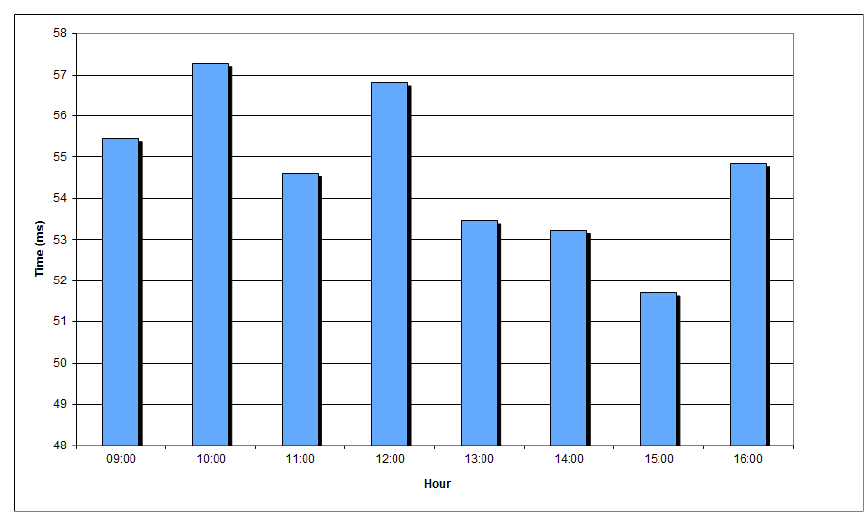
Figure 9. Latency rate in a time interval wih the MiniGrid.